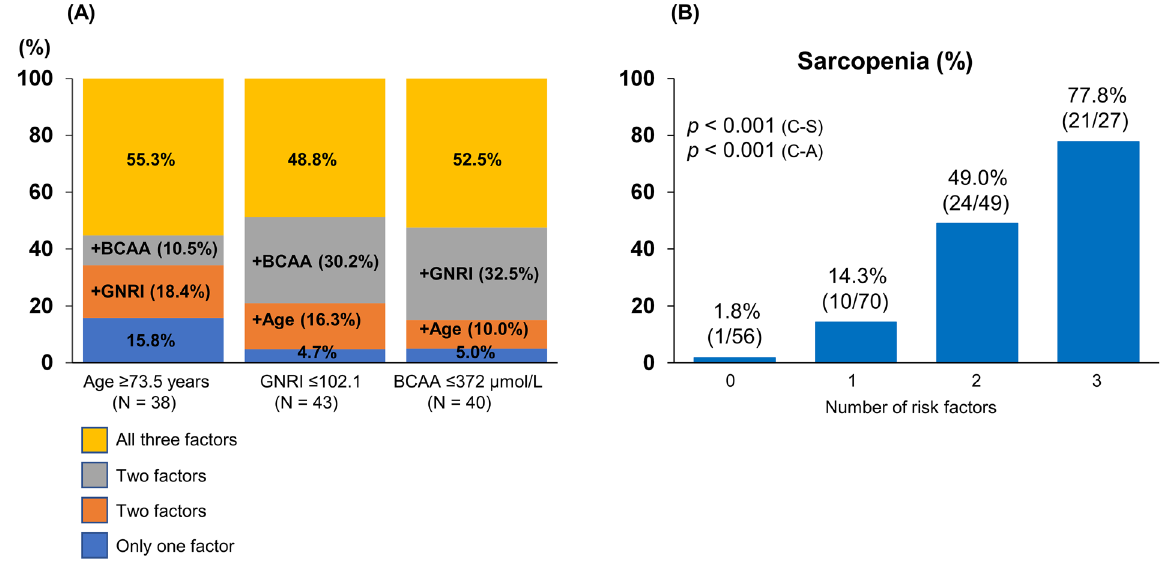
Figure 4. ( A ) Proportion of the number of risk factors in each risk group (age ≥ 73.5 years, Geriatric Nutritional Risk Index ≤ 102.1, and branched-chain amino acid ≤ 372 µmol/L). ( B ) The prevalence of sarcopenia in each group stratified by the number of risk factors. The prevalence of sarcopenia in the group with all three risk factors was the highest among the four groups (77.8% [21/27]; p < 0.001, adjusted residual = |6.2|), while the prevalence of sarcopenia in the group with no risk factors was the lowest (1.8% [1/56]; p < 0.001, adjusted residual = |5.1|), and its prevalence increased stepwise as the number of risk factors increased ( p < 0.001). C–A Cochran–Armitage test; C–S Chi-squared